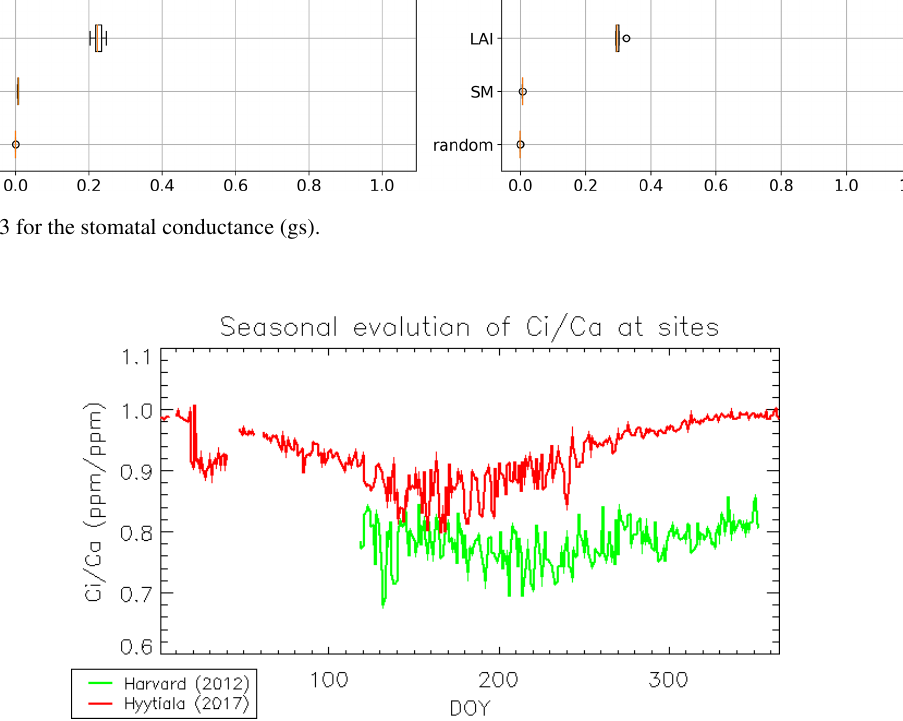
Figure B5. Seasonal evolution of the simulated C i -to- C a ratio at the Harvard Forest site in 2012 (green curve) and the Hyytiälä site in 2017 (red curve).